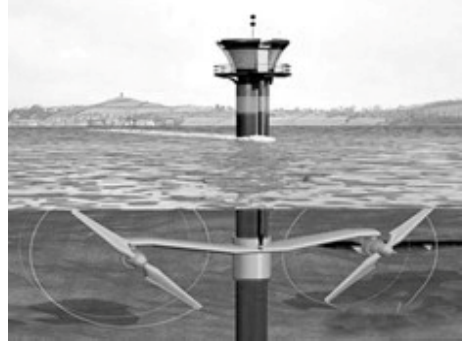
Figure 3. Turbine of the Marine Current Turbines Ltd.